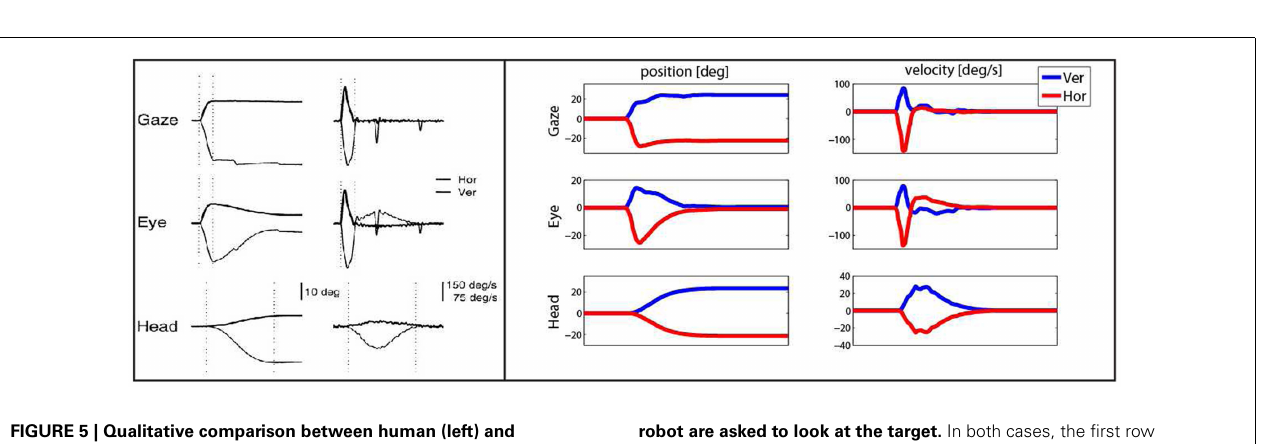
FIGURE 5 | Qualitative comparison between human (left) and iCub (right) saccadic responses: position (first column) and velocities (second column) of the head and the eye movements (both horizontal and vertical) are given when the human and the